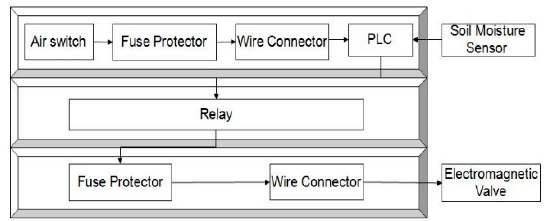
Figure 5. Design chart of the F-PLC employed in this study. PLC, programmable logic controller.